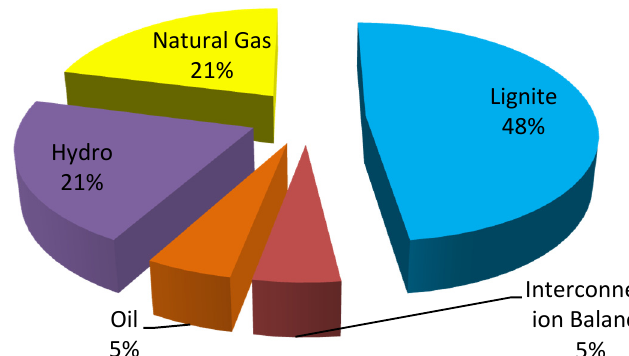
Figure 6. Greek Annual Share of Fuels for 2010 [25,45] (2010 National Report to the European Commission by Regulatory Authority for Energy in Greece based on data provided by